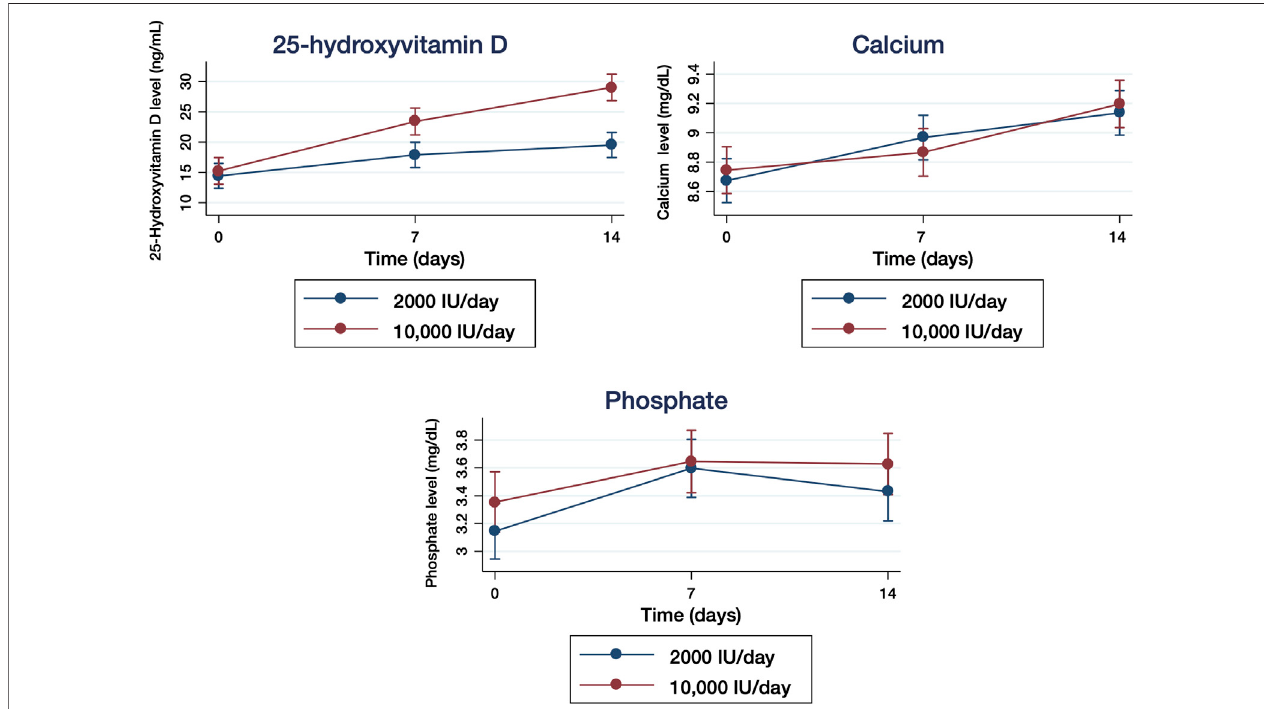
FIGURE 2 | Quanti fi cation of serum 25-hydroxyvitamin D (25(OH)D) levels (mg/ml) (A) , calcium level (mg/dl) (B) , and phosphate level (mg/dl) (C) in hospitalized patientswithCOVID-19whoreceived2000IU/dayand10,000IU/dayofcholecalciferolmeasuredatbaseline(day0)andafter7and14daysoftreatment.Theresultsare presented as means ±95% of con fi dence intervals.